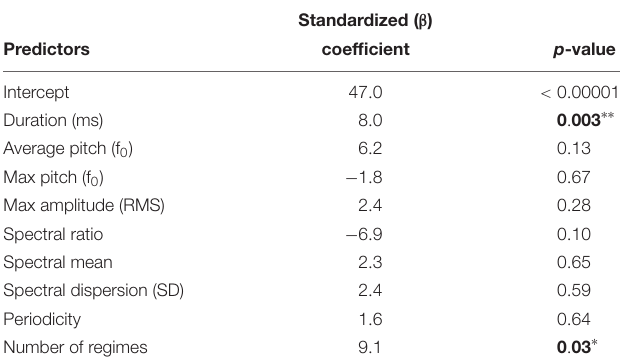
TABLE 1 | Standardized coefficients and relative contribution to the full model of each acoustic predictor of distress ratings ( ∗ p < 0.05, ∗∗ p < 0.001).